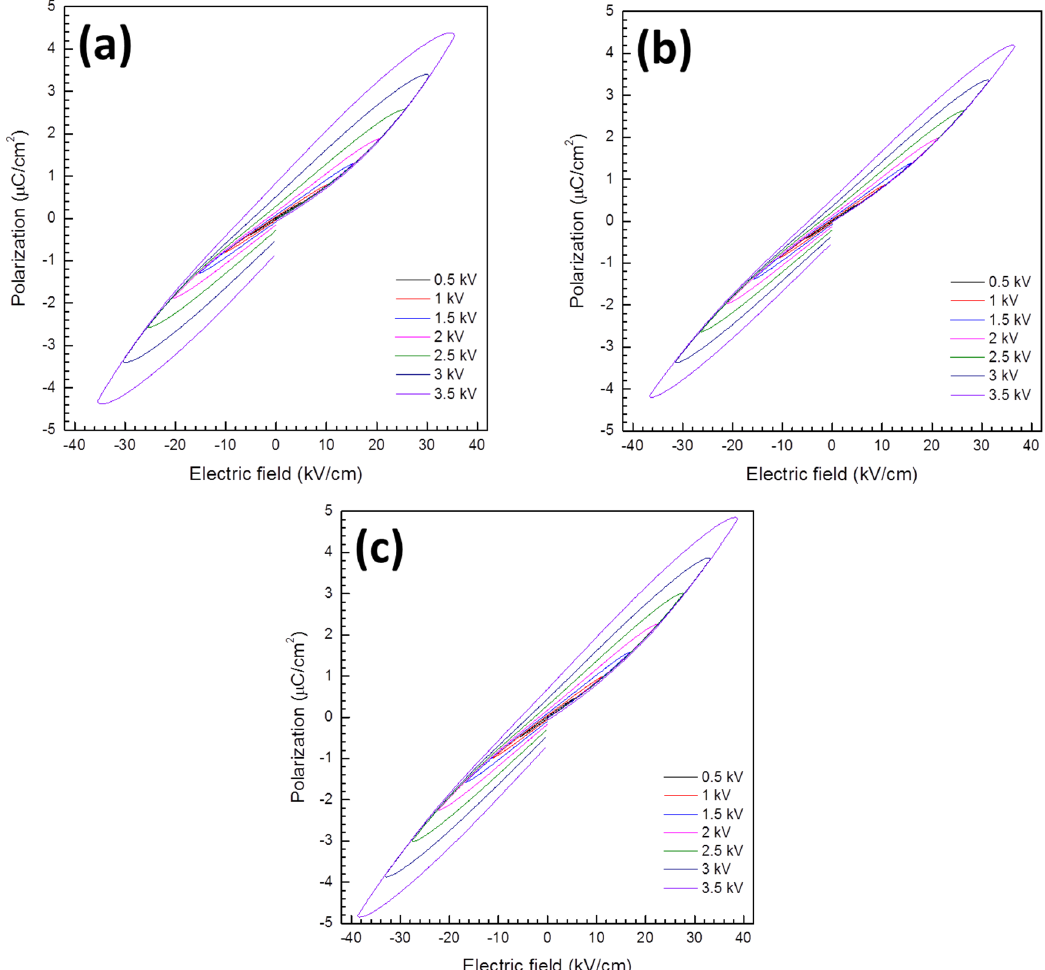
Figure 7. Polarization vs. electric field for 0.4(K 0.5 Bi 0.5 )Ti (1 − x ) Nb x O 3 ‐ 0.6BiFe (1 − x ) Nb x O 3 samples sintered at 1050 °C for 1 h: ( a ) x = 0.00; ( b ) x = 0.01; and ( c ) x = 0.03.